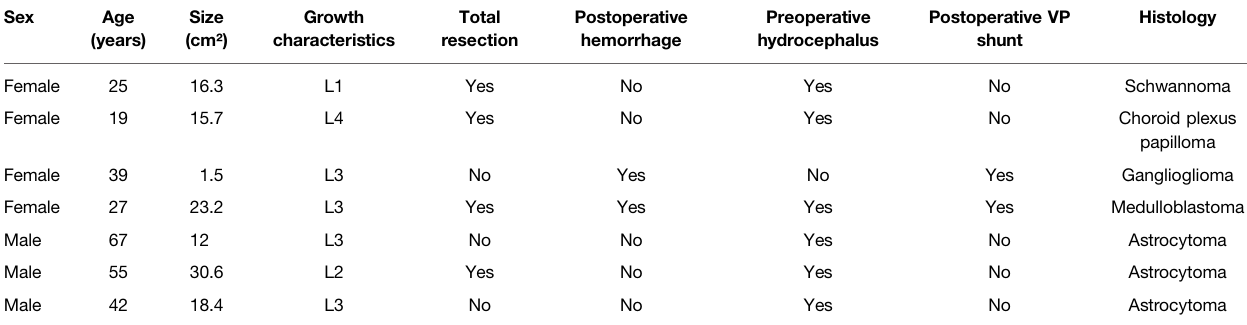
TABLE 1 | Details of the prophylactic EVD